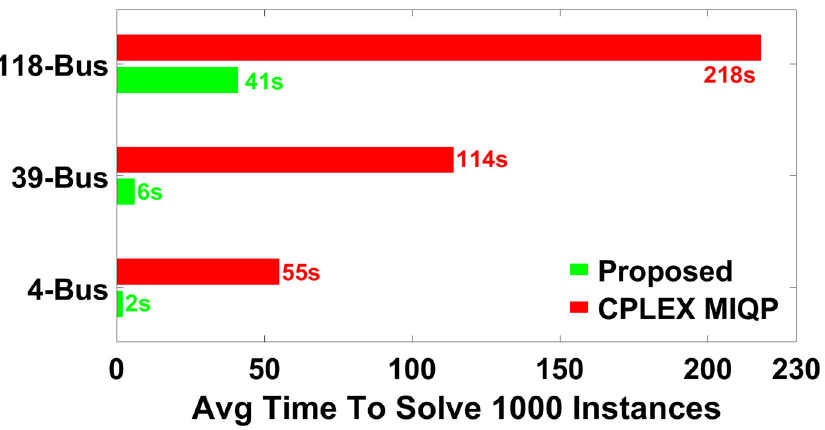
Figure 16. Computational Time